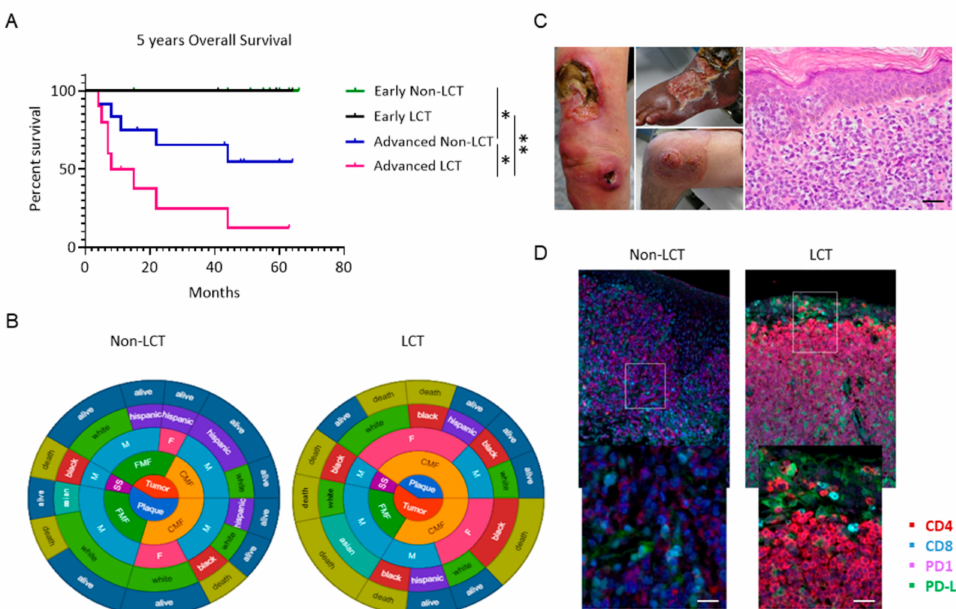
Figure 1. Kaplan–Meier analysis shows significantly decreased survival of patients with LCT-MF compared to non-LCT-MF. ( A ) The overall survival of early non-LCT (green) or early LCT-MF (purple) patients was compared to advanced non-LCT (blue) or advanced LCT-MF patients (magenta) and determined by Mantel–Cox test with p value < 0.05 considered significant ( n = 28). * p < 0.05, ** p < 0.01. ( B ) Circular charts show the distribution of demographic characteristics including stage, MF subtype, gender, race, and survival status of LCT and non-LCT patients. ( C ) Clinical presentation of patients with LCT-MF and Hematoxylin and Eosin (H&E) staining of the LCT-MF lesional skin. Scale bar = 50 µ m. ( D ) Representative multiplex immunofluorescence images of CTCL skin biopsy with LCT-MF and non-LCT-MF. CD4 is stained red; CD8 is blue; PD1 is magenta; PD-L1 is green. Scale bar = 20 µ m.